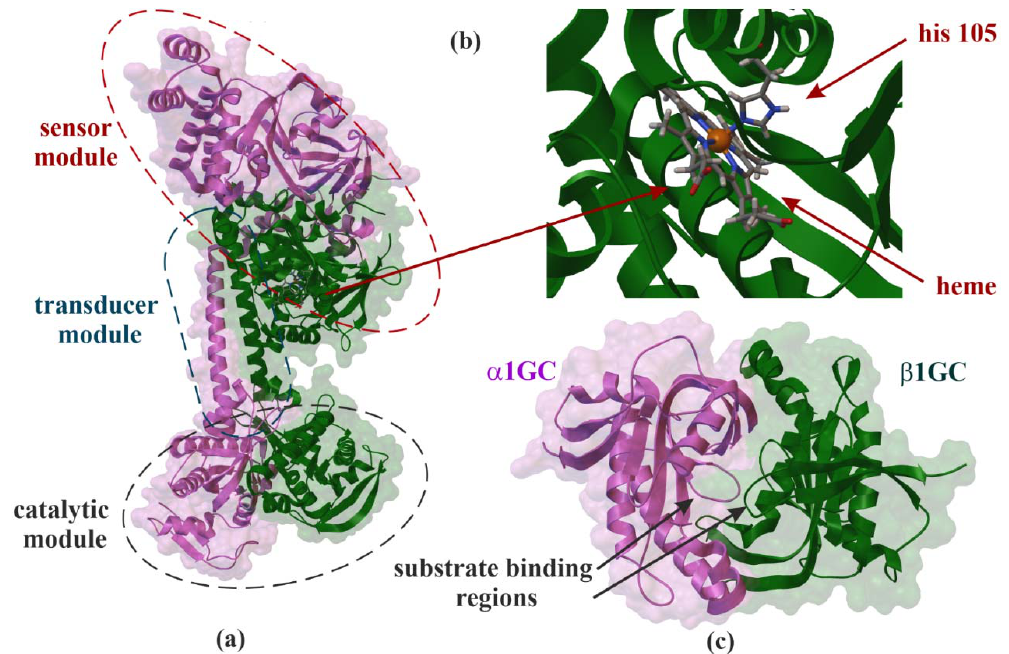
Figure 1. X ‐ ray structure of soluble guanylate cyclase (sGC). Domain organization of the human α 1 β 1GC heterodimer (PDB ID: 6JT1, 3.9 Å) ( a ) [16], interaction side view between heme and histidine 105 (his 105) ( b ) and α 1 β 1GC catalytic domains that resembles the Chinese yin ‐ yang symbol with both subunits arranged in a head ‐ to ‐ tail conformation (PDB ID: 4NI2, 1.9 Å) ( c ) [17].